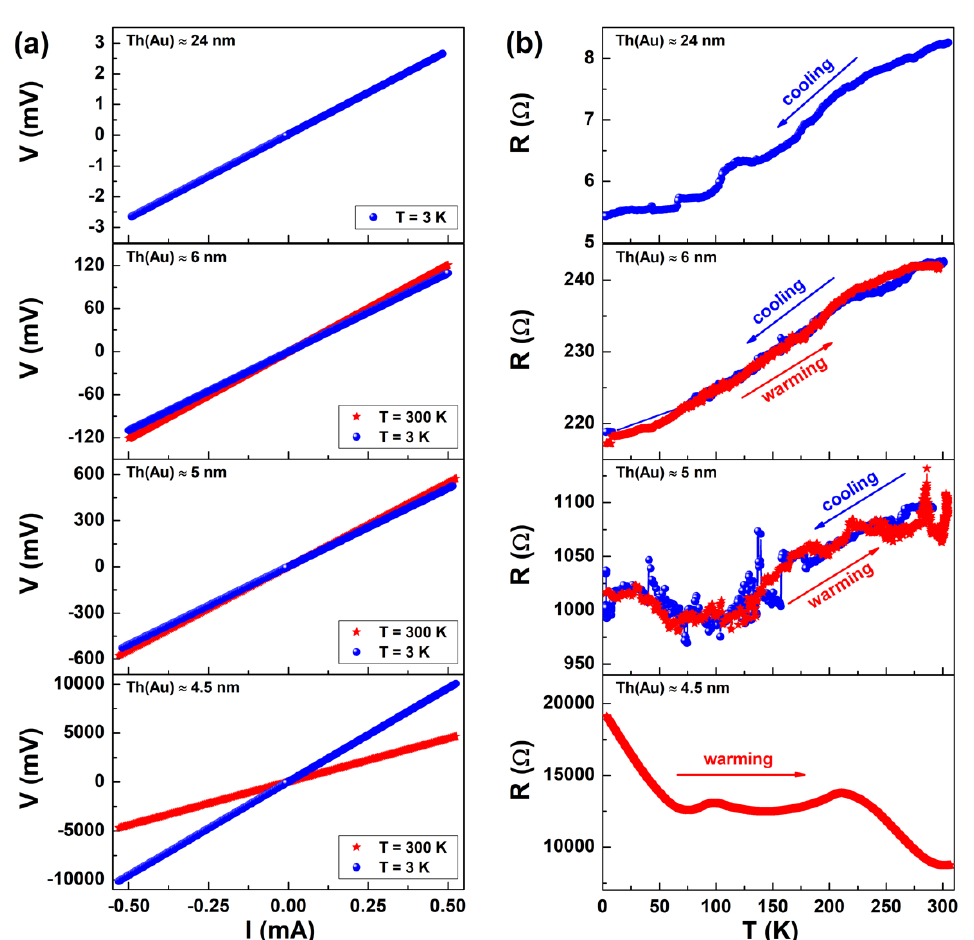
Figure 1. DC electrical characterization of four sodium–alginate (SA) samples sputtered with Au, with a thickness ranging from 4.5 to 24 nm. ( a ) Current–voltage ( I - V ) curves. Red stars data refer to 300 K, while blue circles refer to 3 K. ( b ) Resistance versus temperature ( R - T ) curves are reported for the same samples. The curves, acquired in cooling (blue circles) and warming (red stars) modes, did not show any significant hysteresis.